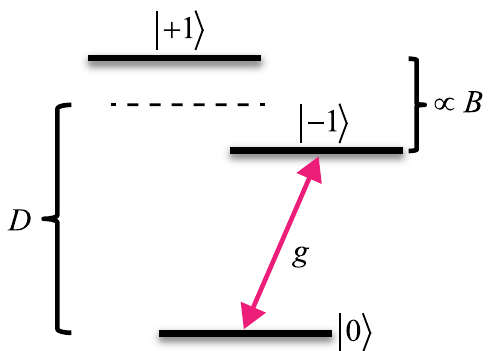
Figure A5: Level structure of a single NV spin in the electronic ground state. This is a spin triplet consisting of states | 0 〉 , |− 1 〉 , and |+ 1 〉 . The zero- fi eld splitting is D ≈ 2.87 GHz, while the Zeeman splitting between the states | ± 1 〉 is proportional to the applied magnetic fi eld B . We focus on, e.g., the | 0 〉 → |− 1 〉 transition and assume that this spin transition is coupled to the cavity mode with a strength g .